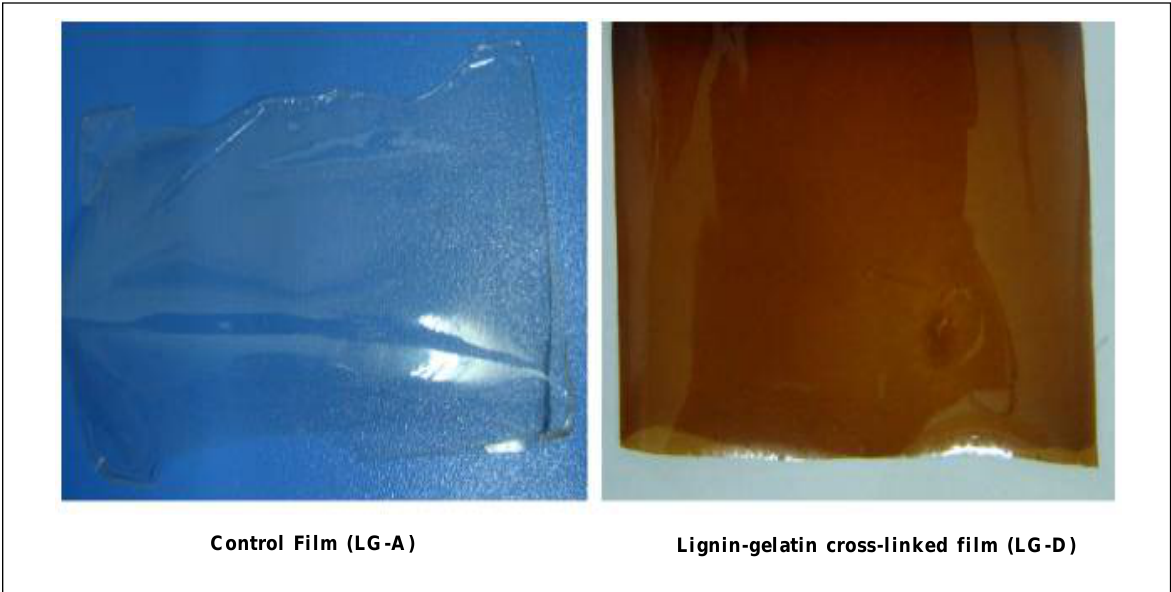
Control Film (LG-A) Lignin-gelatin cross-linked film